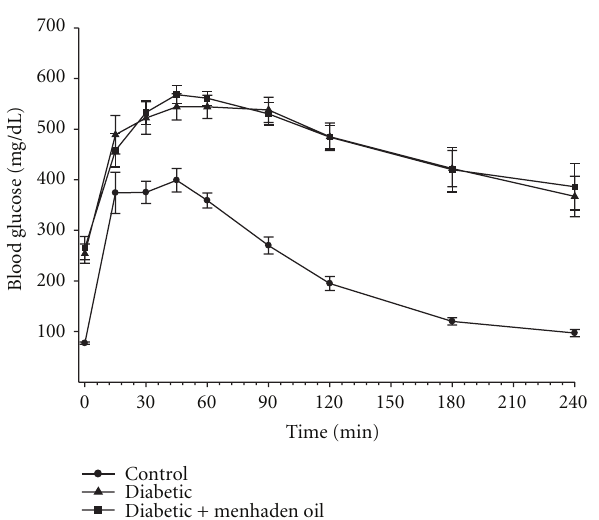
Figure 2: E ff ect of treatment of high-fat/streptozotocin diabetic rats with menhaden-oil- (MO-) supplemented diet on glucose tolerance. Glucose tolerance was determined as described in Section 2. Data are presented as the mean ± S.E.M. in mg/dL. The number of rats in each group was the same as shown in Table 2.